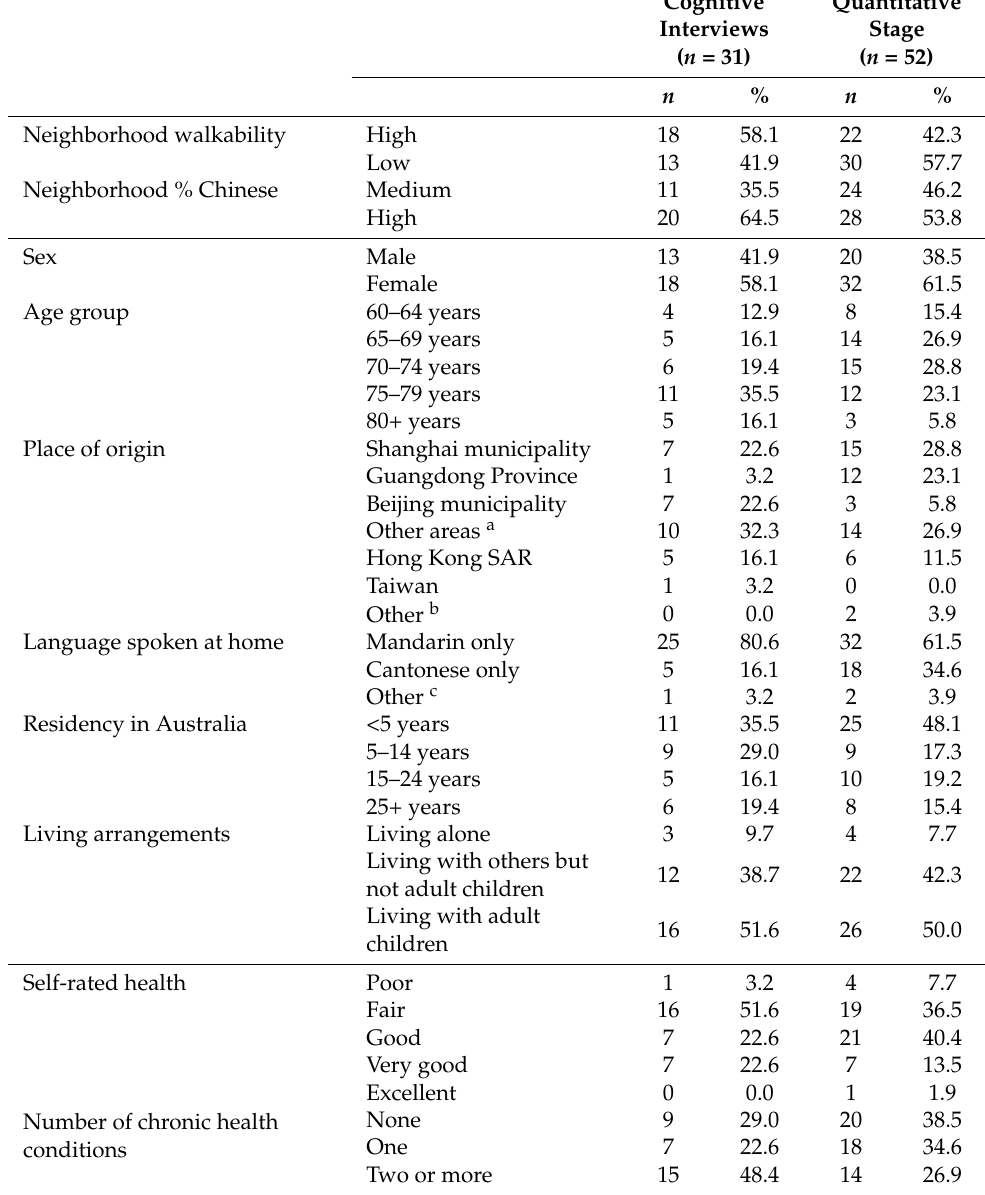
Table 1. Participant socio-demographic and health-related characteristics by study